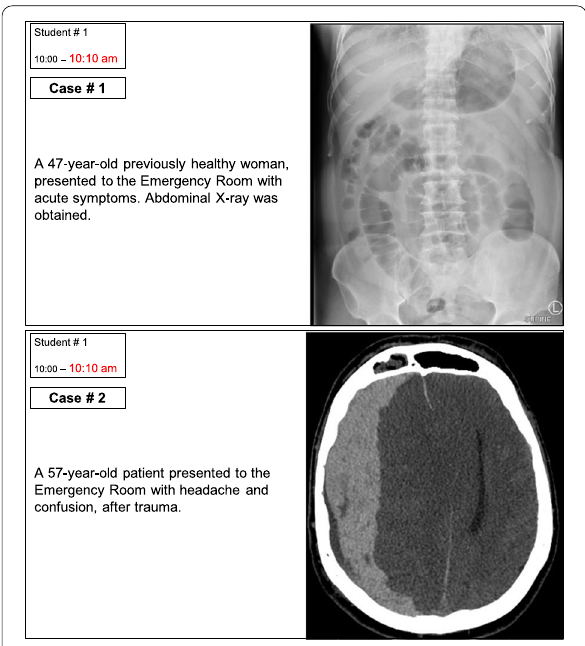
Fig. 1 Sample questions (two of three cases) presented to a student. The left upper corner shows the order of the scheduled student (first students from each batch here) and start time and end time to easily keep track of students. The end time is highlighted in red to alert the